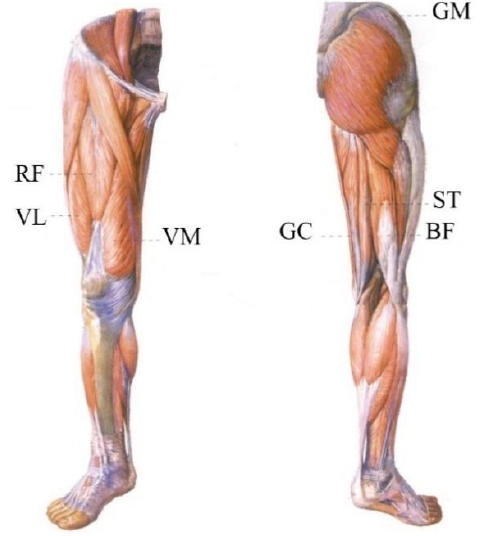
Figure 1. Locations of electrodes in sEMG measurement. Table 1. Information on the subjects.